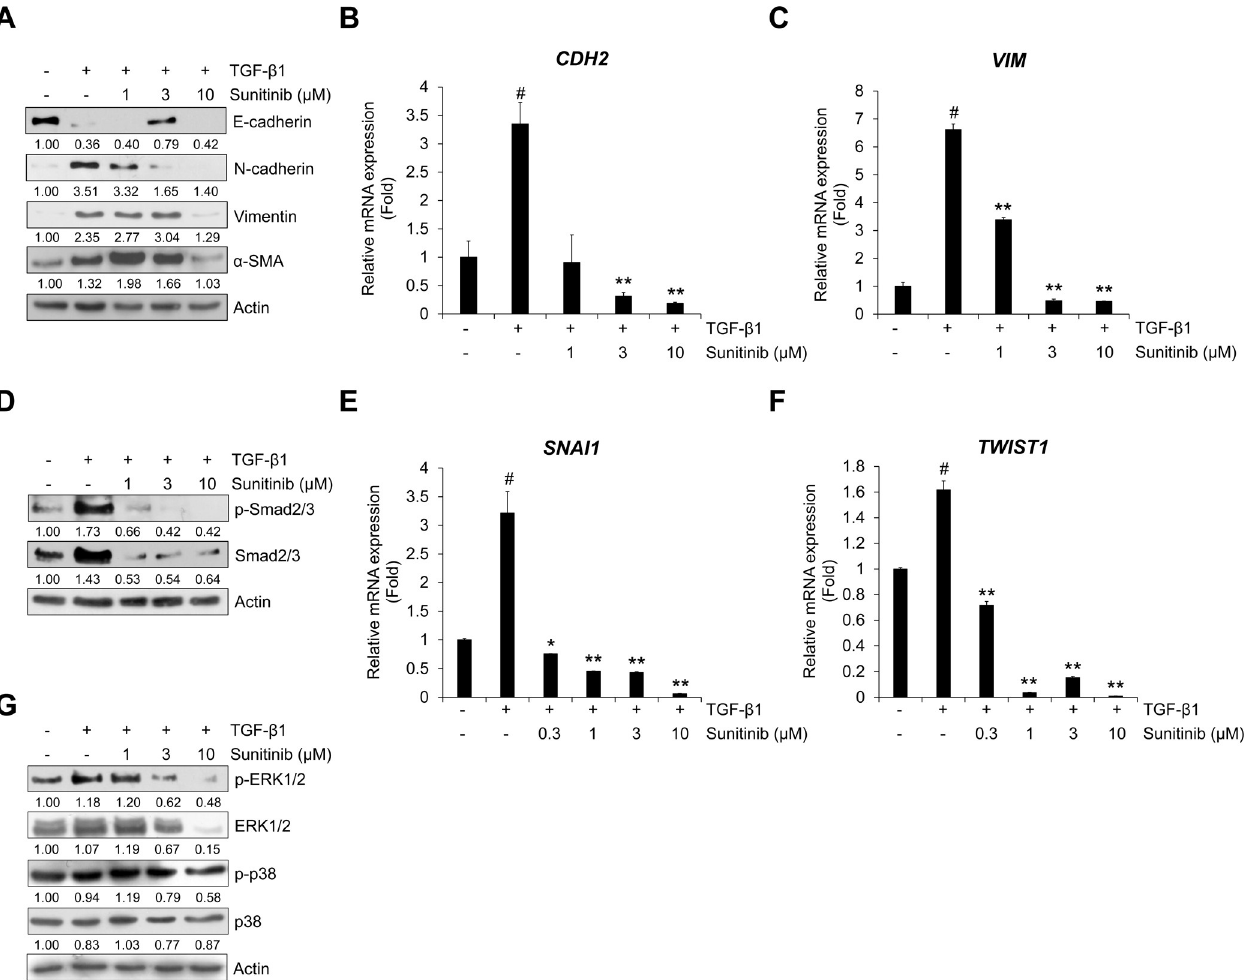
Fig 4. Sunitinib inhibits TGF- β 1-induced expression of EMT markers and Smad signaling. (A) Serum-deprived A549 cells were treated with TGF- β 1 (5 ng/mL) or its combination with sunitinib for 72 h. The protein expression of TGF- β 1-mediatead EMT markers was evaluated by Western blot. Actin was used as a loading control. (B and C) Serum-deprived A549 cells were pretreated with sunitinib for 3 h, and then incubated with TGF- β 1 (5 ng/mL) for 48 h. After RNA extraction and cDNA synthesis, we performed qRT-PCR to measure mRNA expression of CDH2 and VIM using GAPDH as an internal control. (D) Effects of sunitinib on TGF- β 1-activated Smad signaling. A549 cells were treated with TGF- β 1 (5 ng/mL) or its combination with sunitinib for 24 h, and then the levels of p-Smad2/3 and endogenous Smad2/3 in cytosolic fraction were evaluated by Western blot. (E and F) The transcriptional activity of SNAI1 and TWIST1 was measured by qRT-PCR using GAPDH as an internal control. Serum-deprived A549 cells were pretreated with sunitinib for 3 h, and then incubated with TGF- β 1 (5 ng/mL) for 1 h. (G) The effect of sunitinib on TGF- β 1-induced phosphorylation of ERK1/2 and p38 was determined by Western blot. Actin was used as a loading control. # p < 0.01 versus control, � p < 0.05, �� p < 0.01 versus treatment with TGF- β 1 only.